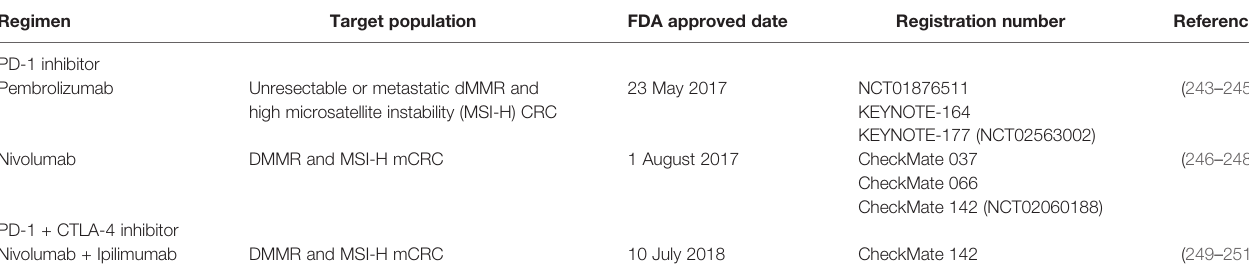
TABLE 3 | FDA approved main agents of immune checkpoint inhibitors (ICIs) for colorectal cancer (CRC). Regimen